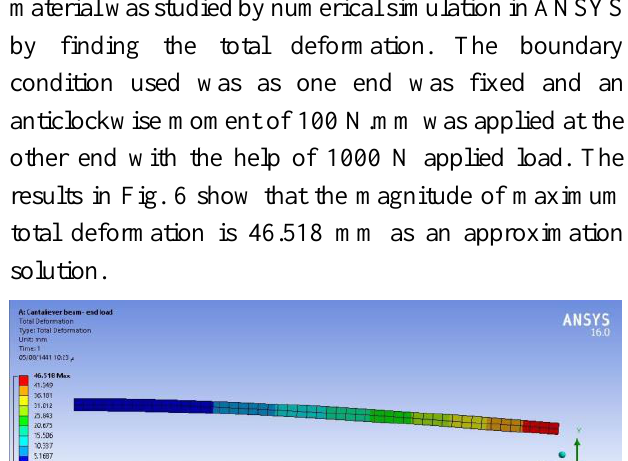
Fig. 8. MATLAB graph for calculation of total deformation for cantilever beam